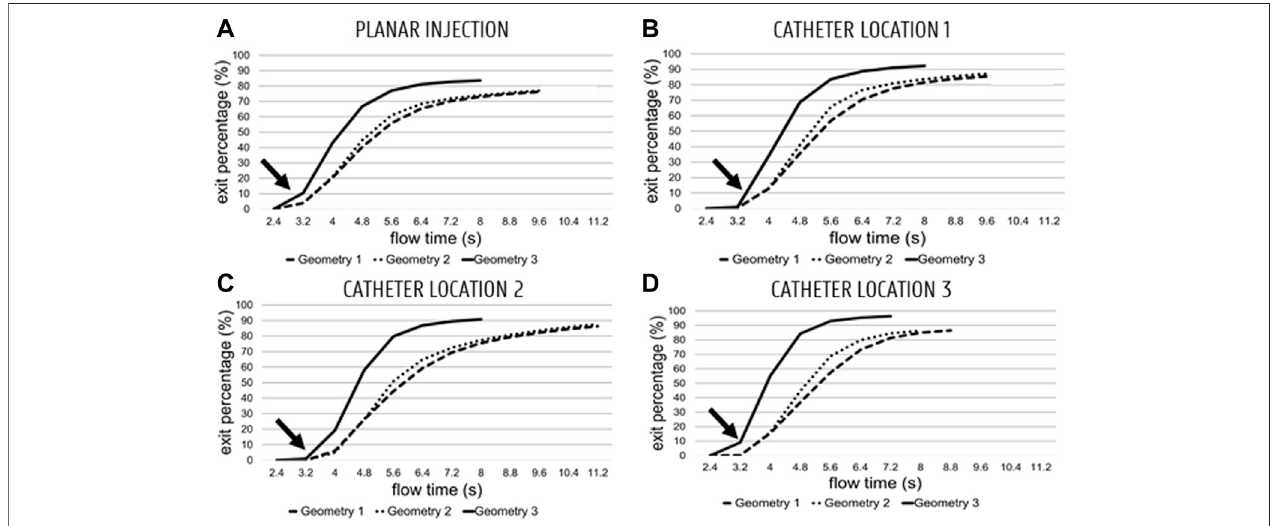
FIGURE 6 | Cumulative particle exit fractions for Geometries 1 – 3 (Geometry 3 is the top curve, Geometry 1 – 2 are the dashed curves) plotted against fl ow time (plotted from the start of the fourth fl ow cycle onwards; 2.4 s). (A) Planar injections. (B – C – D) catheter locations 1, 2 and 3, respectively. Globally, particles start exiting starting at the start of the 5th cycle (3.2 s — see arrow).